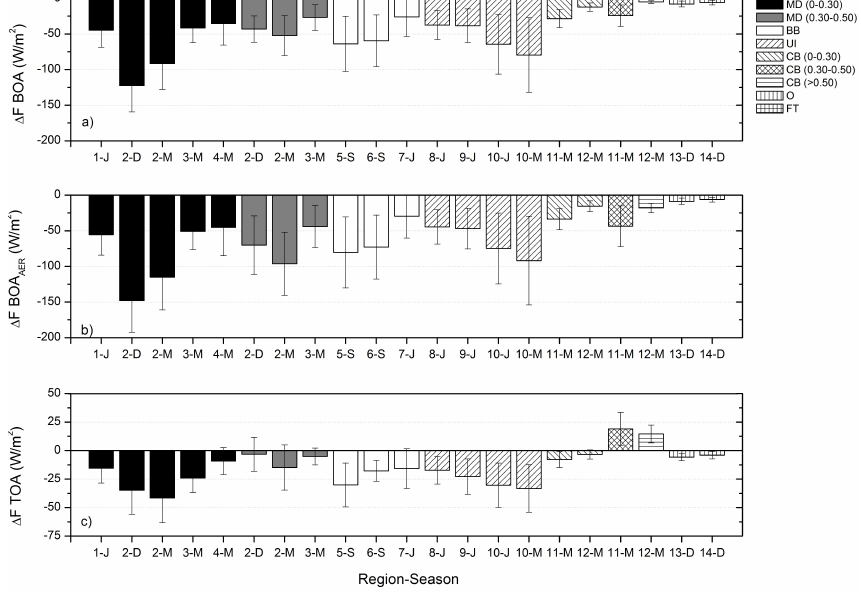
Fig. 6. Multi-year average of the aerosol radiative forcing, 1F (Wm − 2 ), at the BOA (Eq. 3) (a) , AERONET 1F BOA AER at the BOA (Eq. 5) (b) , and 1F at the TOA (Eq. 2) (c) for each region and season. The seasons and aerosol types are labeled as Fig. 5. Error bars indicate ± 1 σ ( σ , standard